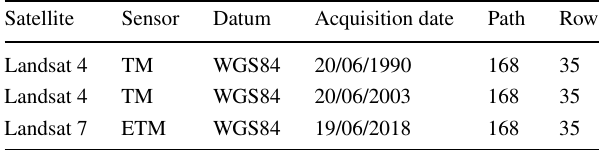
Table 1 Data source to detect land-use changes in Zrebar Lake basin Satellite